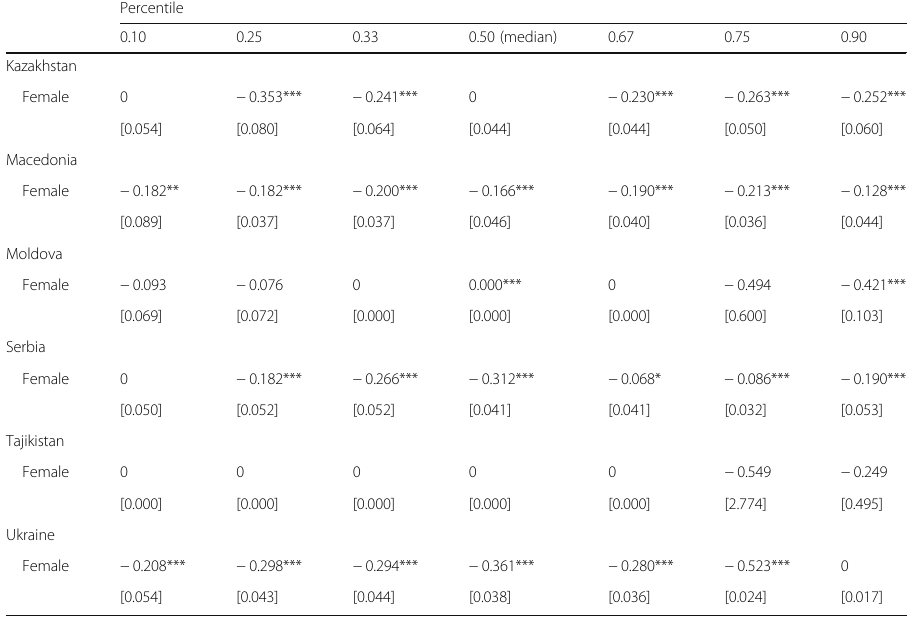
Table 11 Female quantile regression coefficients from pooled Mincer income regressions